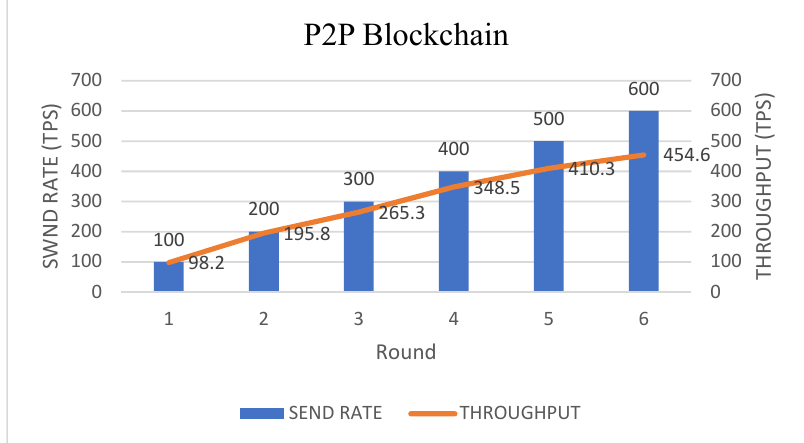
Figure 44. Comparison of transaction volume and throughput in P2P architecture.